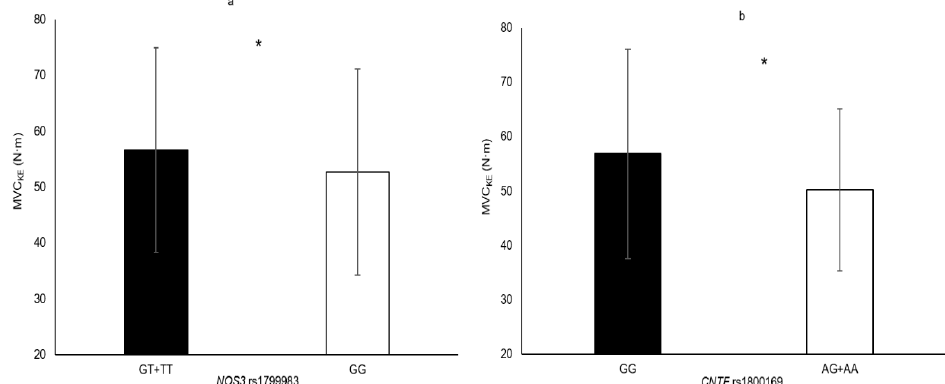
Figure 3. Isometric knee extension maximum voluntary contraction in genotype groups for ( a ) NOS3 rs1799983 (GG = 117 vs. GT + TT = 185, Δ = 7.5%); ( b ) CNTF rs18000169 (GG = 222 vs. AG + AA = 80, Δ = 13.2%). * denotes significant difference. Data are mean ± SD.